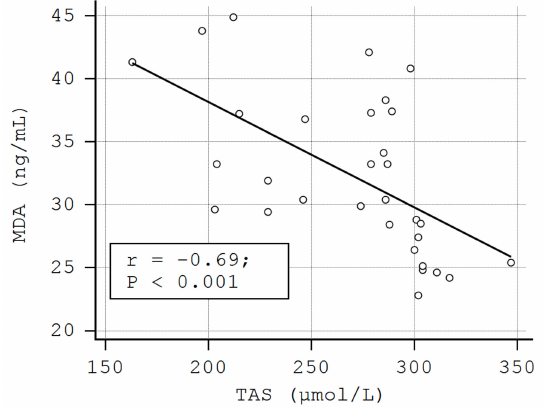
Figure 2. The correlation between the serum levels of thiobarbituric acid reactive substances (TBARS) and TAS in LP patients.